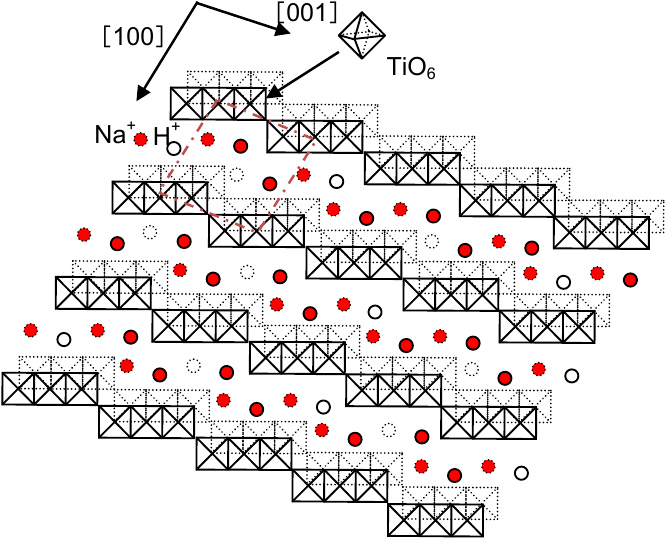
Figure 14. Structure of sodium hydrogen titantate